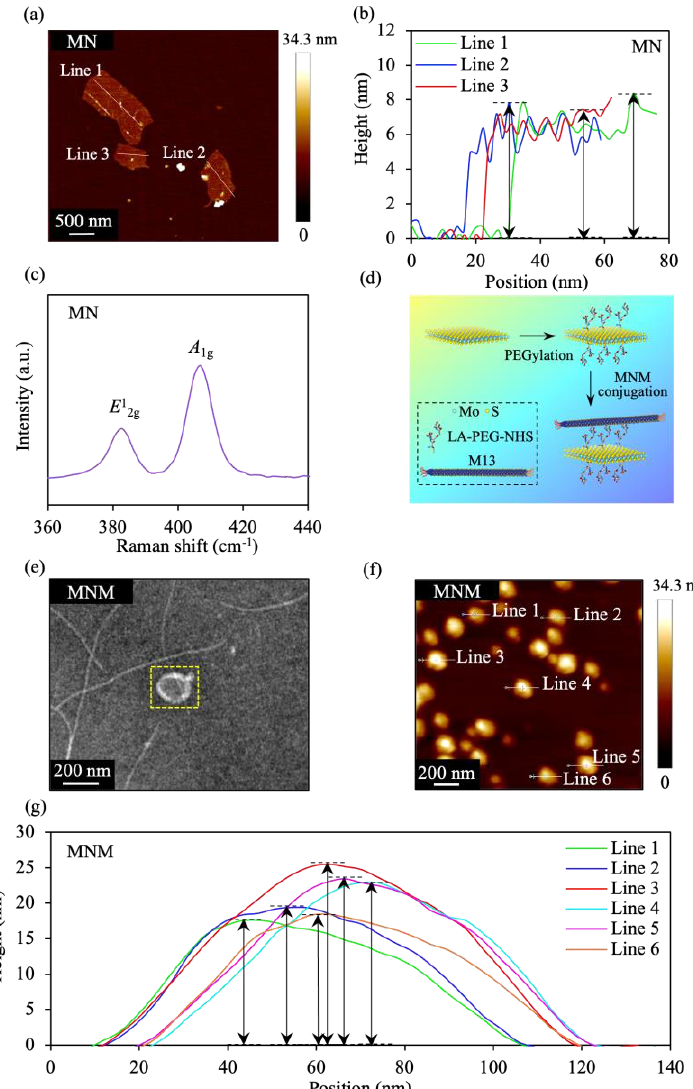
Figure 3. Characterization of the MN and MNM. ( a ) AFM image of MN. ( b ) Height profiles of the MN, along the white lines in ( a ). ( c ) Raman spectra of MN. ( d ) Schematic diagram of the composition and process utilized to construct MNM. ( e ) TEM image of MNM. The yellow dashed boxed area contains the head/ sheet-type structure. TEM images of the M13 phage with a diameter of ~10 nm and also a length of ~1 µm have been shown in M13-type samples harnessed by other research groups [78 – 80,84]. Our results are similar, since a similar TEM image was achieved for the sample utilized in this work. ( f ) AFM image of MNM. ( g ) Height profiles of the MNM, along the white lines in ( f ).